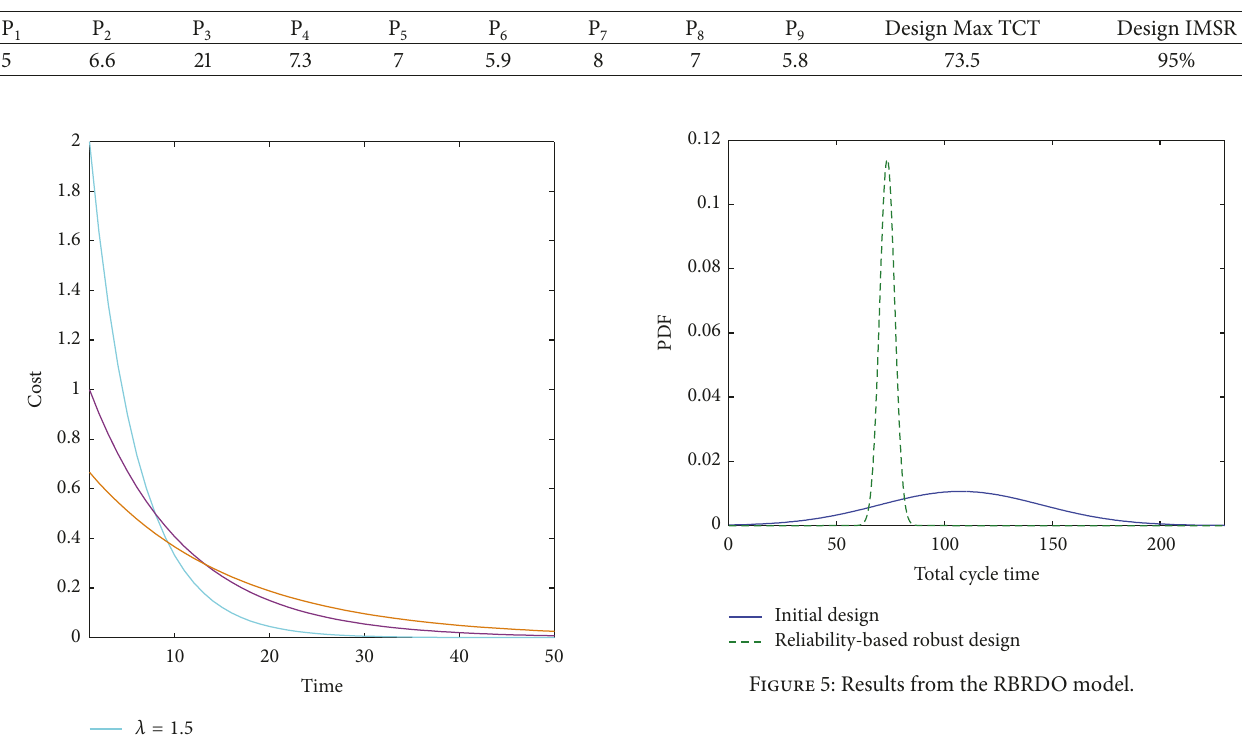
Table 3: Optimized points required to reach the delivery target.